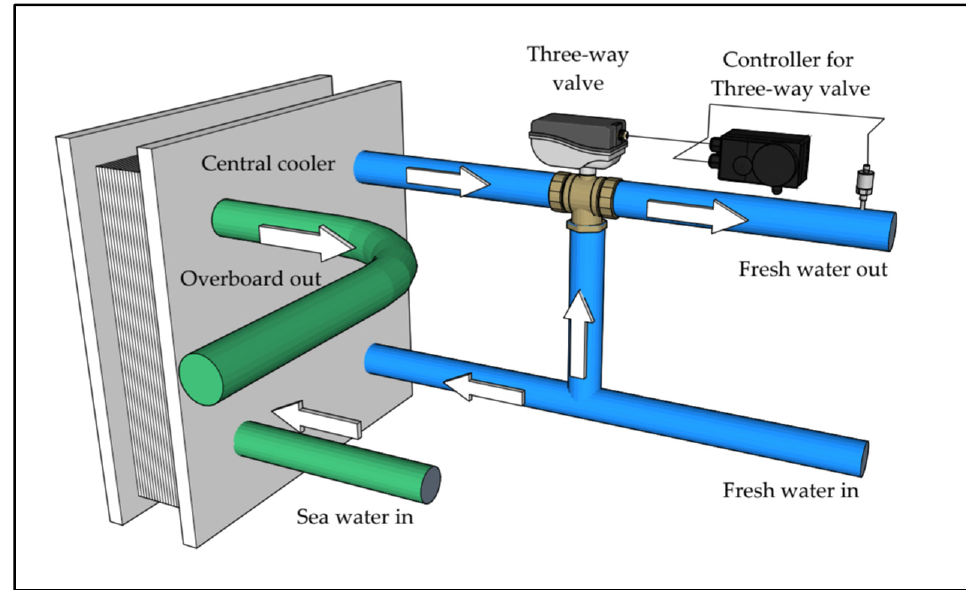
Figure 2. Configuration of central cooling water system.